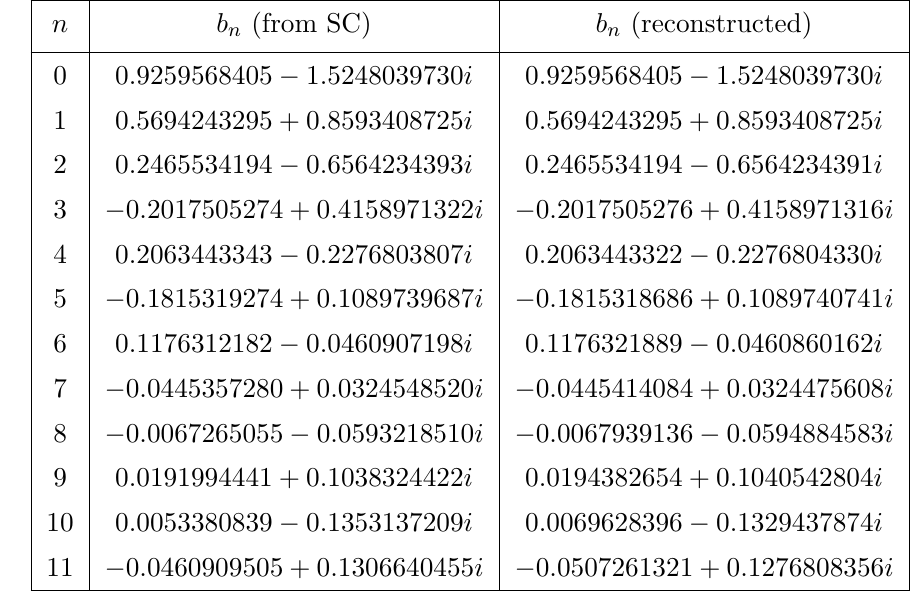
Table 3. Comparison between the N 1 = 12 coefficients b n form the series expansion of w 1 ( z ) calculated directly from the spectral curve (SC) and those reconstructed by using the Darboux